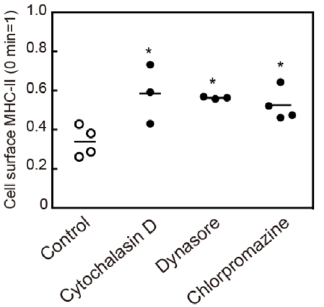
Figure 6. Effect of endocytosis inhibitors on crosslinking-induced MHC-II endocytosis. BMDCs were pre-incubated with cytochalasin D (3 µM), dynasore (100 µM), or chlorpromazine (30 µM), for 30 min at 37 °C. The cell surface MHC-II was crosslinked with an anti-MHC-II antibody for 30 min. The remaining cell surface MHC-II was detected by flow cytometry. Values of * p < 0.05 are regarded as significant.